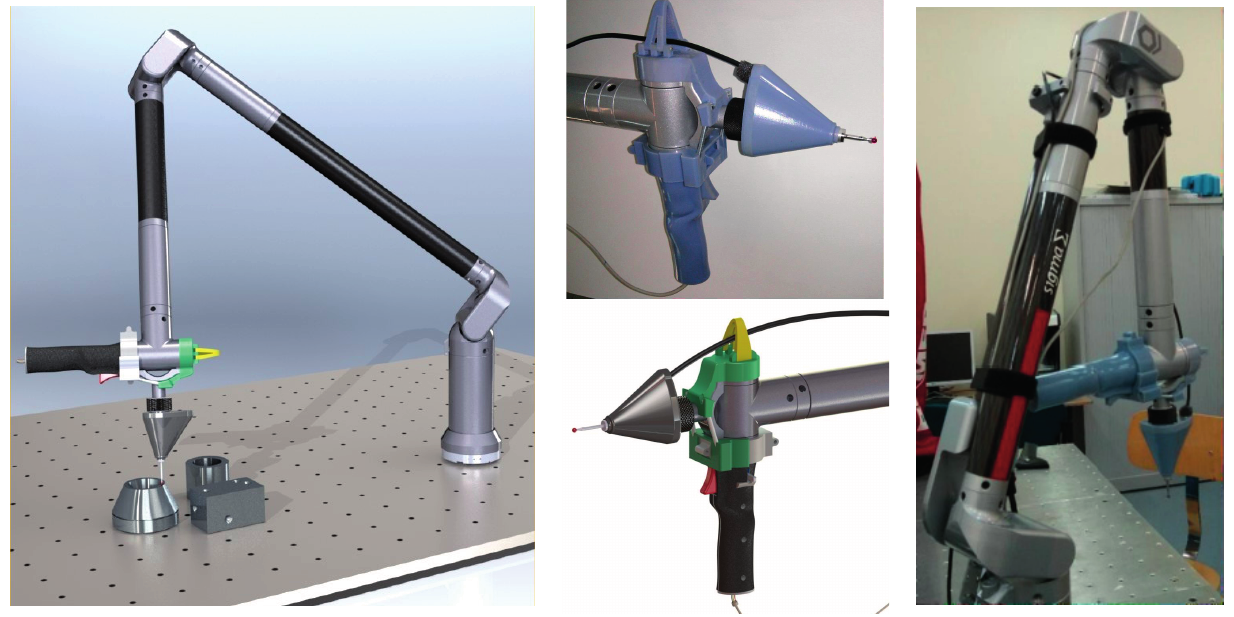
Figure 6. Details of the final sensor device, from concept to the real